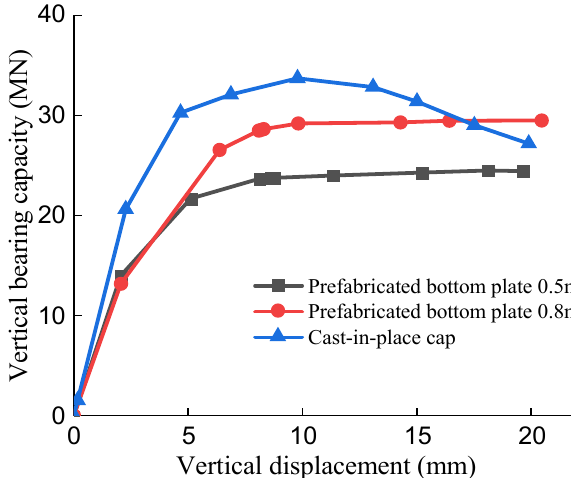
Figure 24. Comparison of different base plate thicknesses.